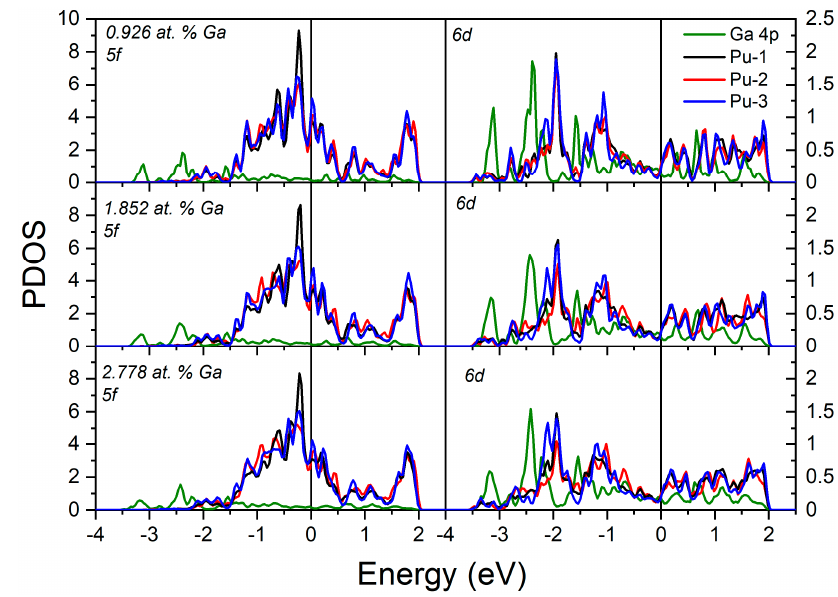
Figure 8. Partial density of states for the 0.926, 1.852, and 2.778 at. % Ga concentrations with no defects. The Pu 5f6d states shown for Pu atoms at various distances from the Ga atom (Table